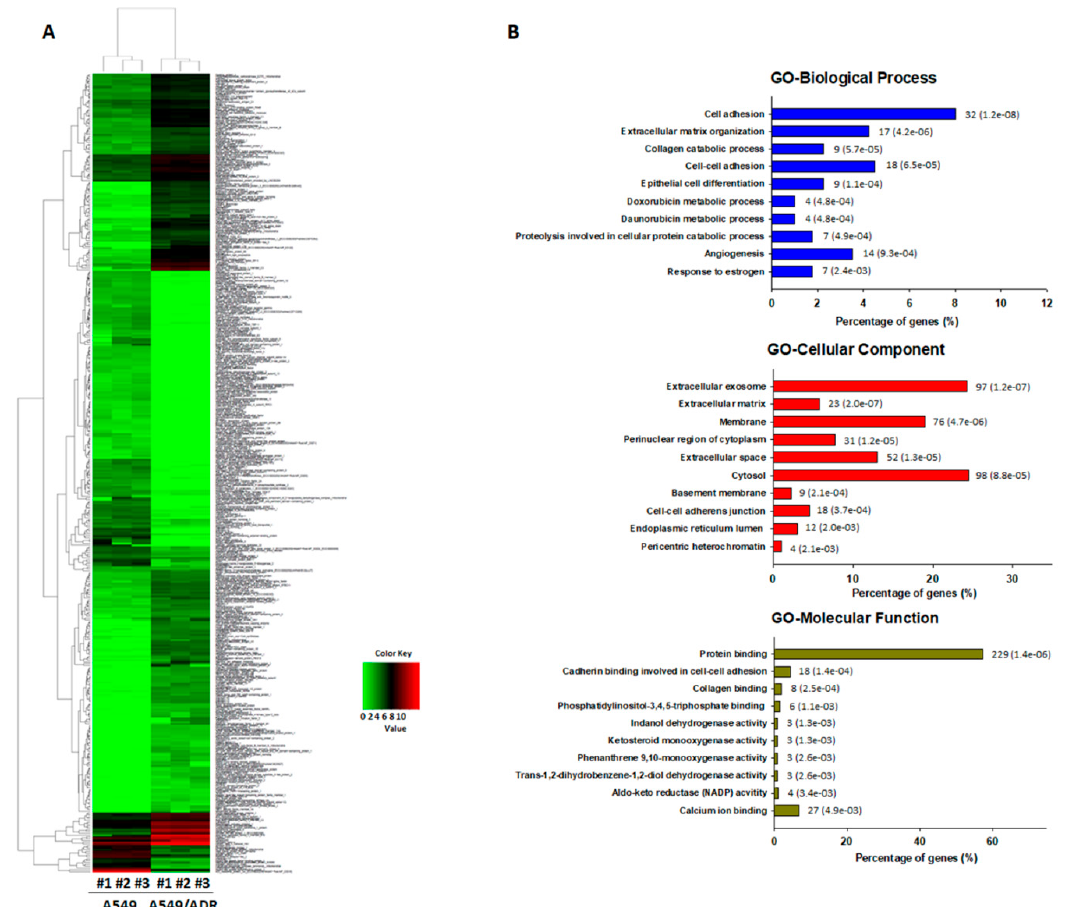
Figure 2. Analysis of differentially expressed genes (DEGs) in A549/ADR cells compared to A549 cells. ( A ) Heatmaps of gene expression data are shown for all samples. Representation of the log2-transformed values from 400 cellular genes identified as significantly altered in A549/ADR cells compared to A549 cells. ( B ) Top 10 pathways enriched by Gene Ontology (GO) analysis of DEGs in A549/ADR cells. The horizontal axis shows the percentage of annotated genes compared to the total gene number. The vertical axis shows the specific categories in each biological process, cellular component, and molecular function for GO as investigated by the Database for Annotation, Visualization and Integrated Discovery (DAVID) web tool and organized by p -values. The number shown on the right of each bar represents the number of genes, and the number in parentheses represents the p -value. Nutrients 2018 , 10 , x FOR PEER REVIEW